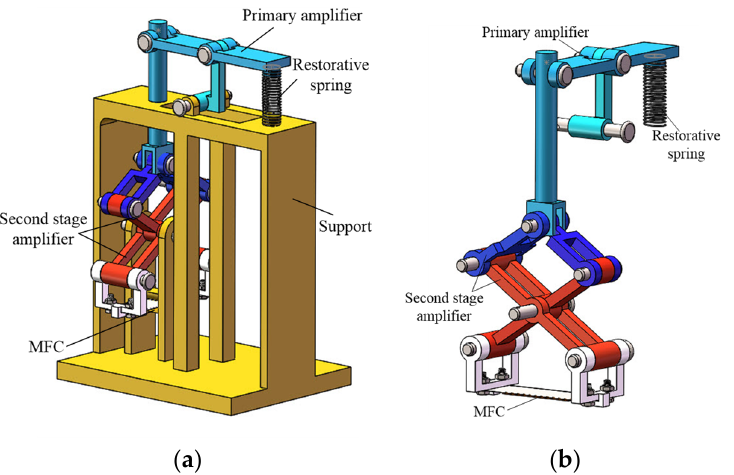
Figure 1. Structure of the vibration piezoelectric generator. ( a ) Overall structure; ( b ) amplitude amplification